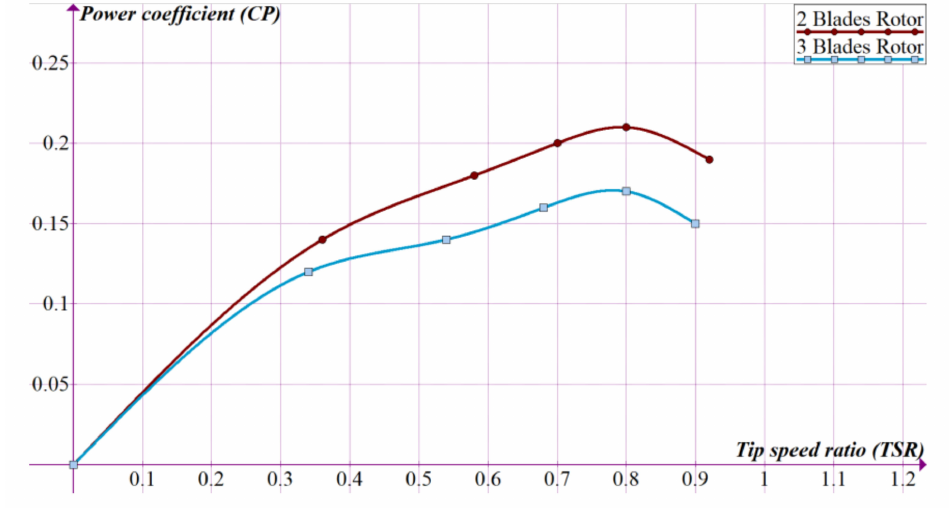
Figure 4. Power coefficient ( CP ) for two- and three-blade rotors